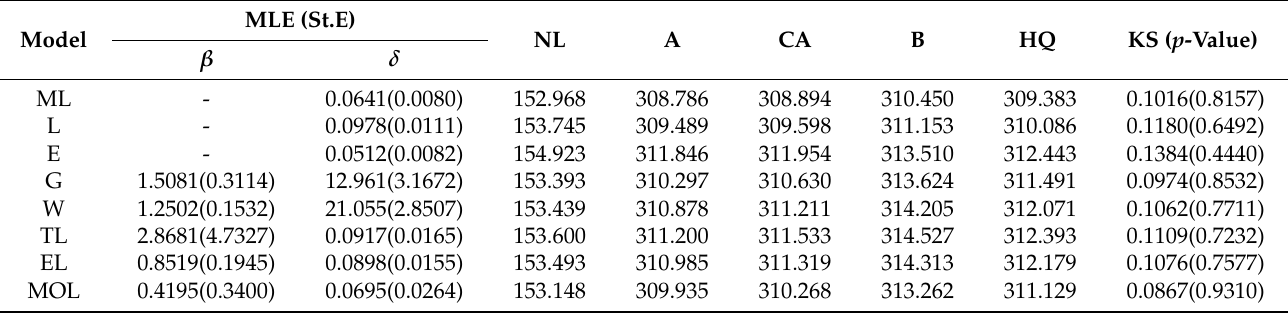
Table 7. Summary of fit of ML and its competitive models from MVAD